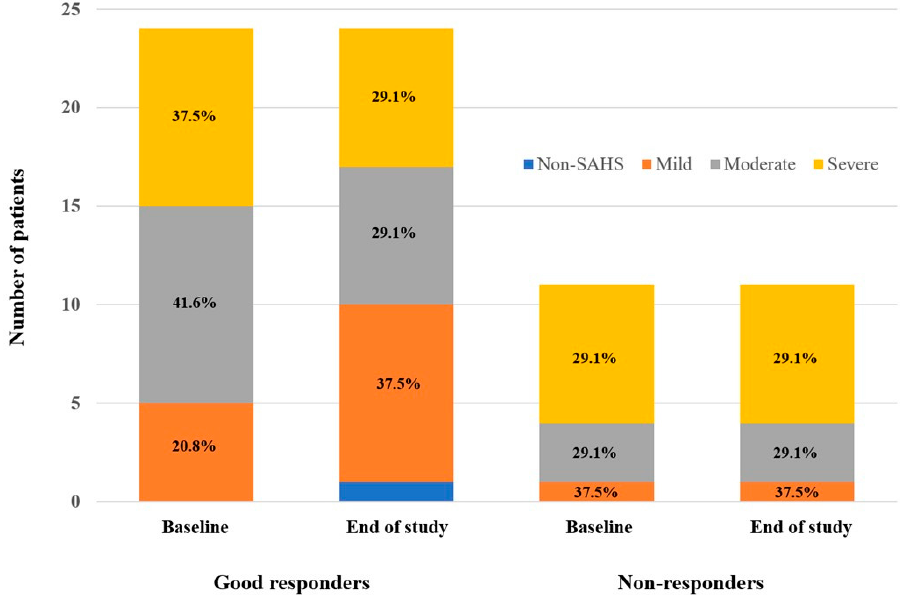
Figure 1. Distribution of the sleep apnea hypopnea syndrome gradation in patients with type 2 diabetes included in the study according to the group (good responders and non-responders) at baseline and after the intensification period. Non-OSA: apnea–hypopnea index (AHI) < 5 events / hour; mild OSA: AHI between 5 and 15 events / hour; moderate OSA: AHI between 15 and 30 events / hour; severe OSA (AHI > 30 events / hour).